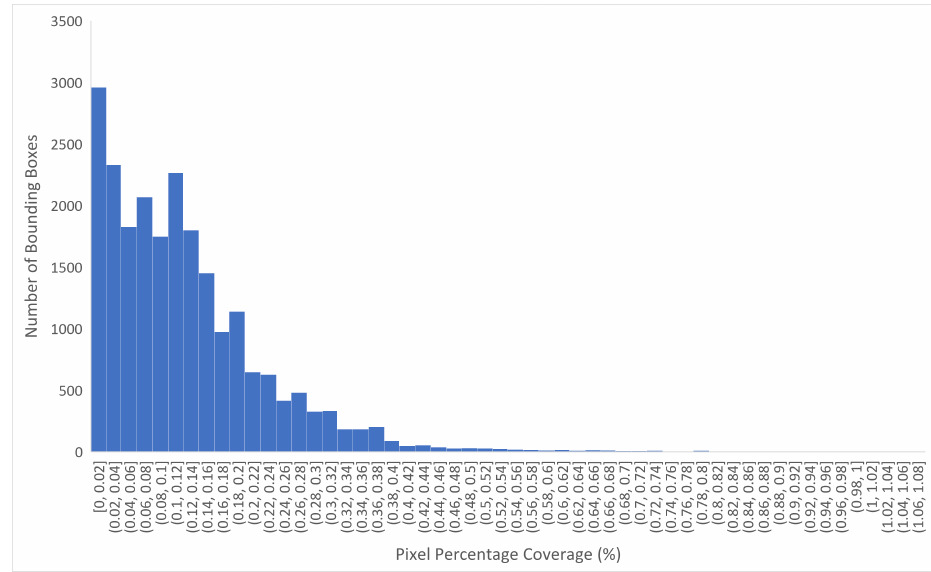
Figure 7. Histogram showing the distribution of pixel percentage cover of the plastic items in comparison to overall image size in the test data set.